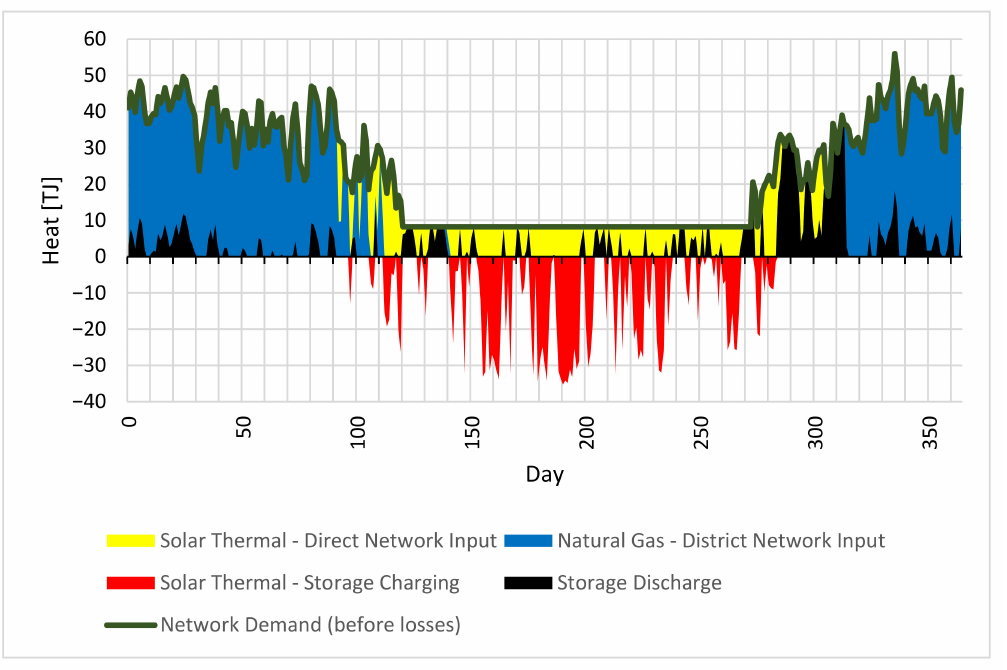
Figure 5. Daily heat flows in the system for the STAT scenario with the share of heat production from solar heating plants at least at the level of 40%.